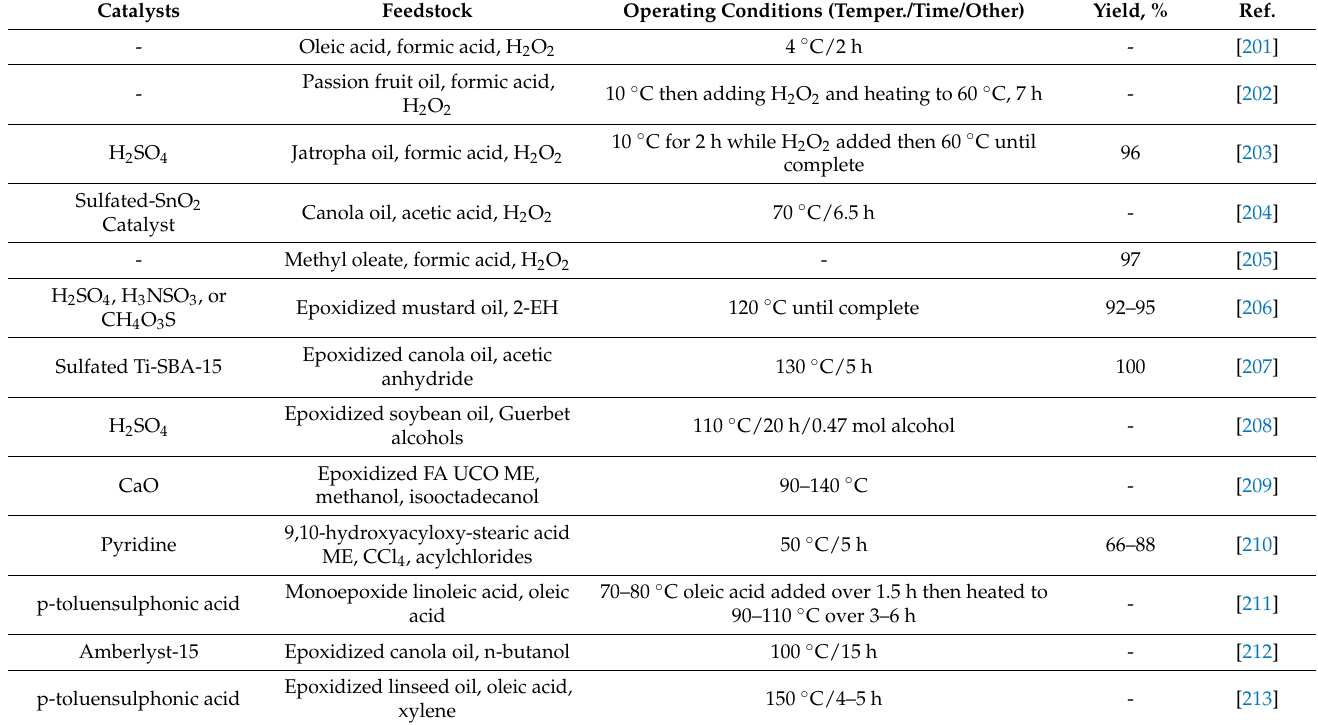
Table 10. The overview of catalysts used for biolubricant synthesis by